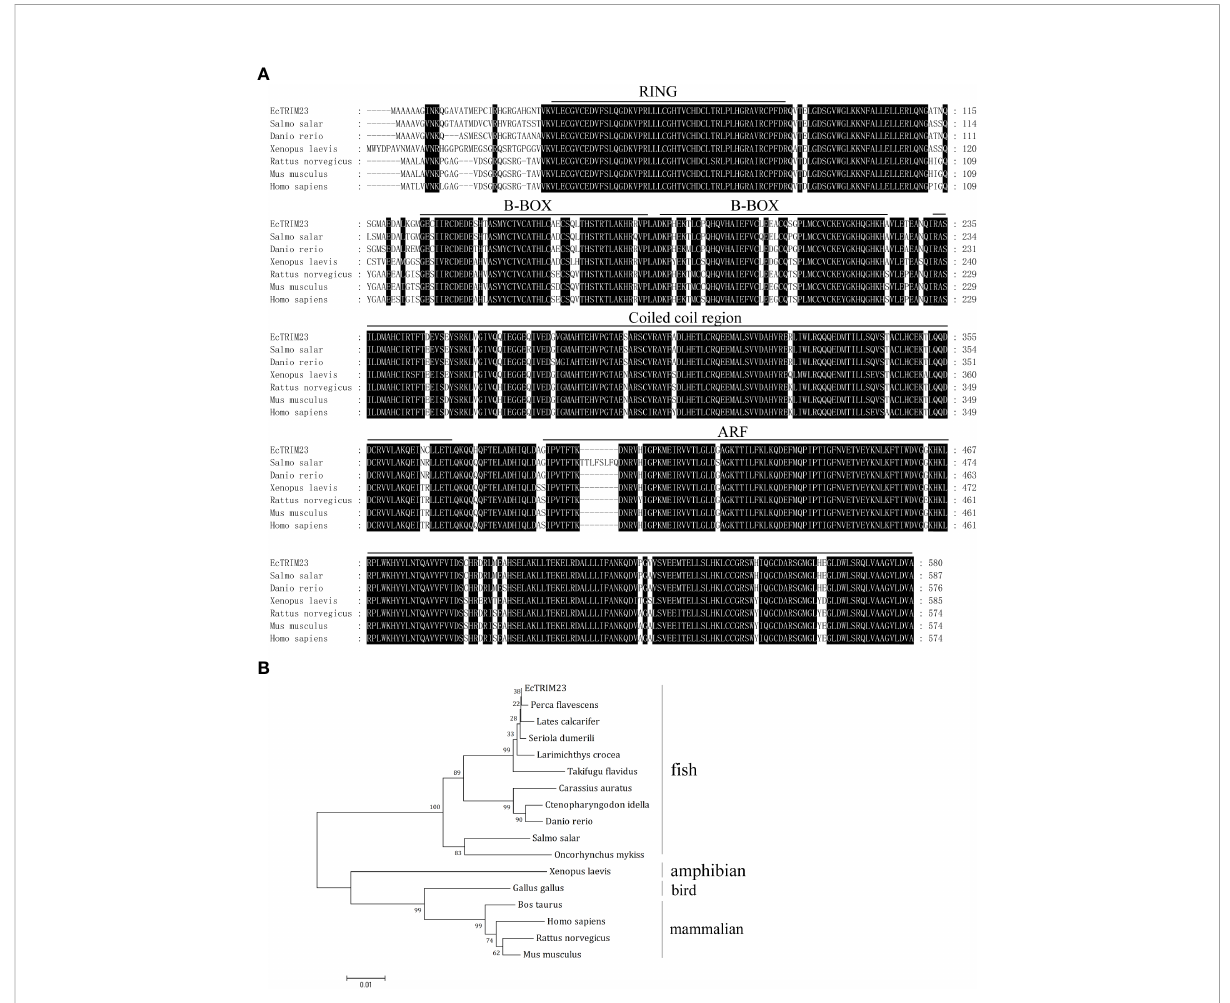
FIGURE 1 Sequence characteristics of EcTRIM23. (A) Amino acid alignment of EcTRIM23 and other TRIM23 homologs from different species. The conserved domains, including RING domain, B-BOX domain, coiled-coil domain and ARF domain are underlined. (B) Phylogenetic analysis of EcTRIM23. A phylogenetic tree was constructed using MEGA 4.0 with the neighbor-joining (NJ) method. The bootstrap values are indicated at the branch points. The sequences of TRIM23 genes used in this study were obtained from GenBank, and their accession numbers are listed as follows: Perca fl avescens , XP_028457727; Lates calcarifer , XP_018517789; Seriola dumerili , XP_022595517; Larimichthys crocea , XP_019134261; Takifugu fl avidus , TWW66274; Carassius auratus , XP_026129098; Ctenopharyngodon idella , QBQ04133; Danio rerio , XP_005155659; Salmo salar , XP_013982389; Oncorhynchus mykiss , XP_021458645; Xenopus laevis , XP_018121234; Gallus gallus , XP_424752; Bos taurus , XP_010815025; Homo sapiens , NP_001647; Rattus norvegicus , NP_001094107; Mus musculus ,